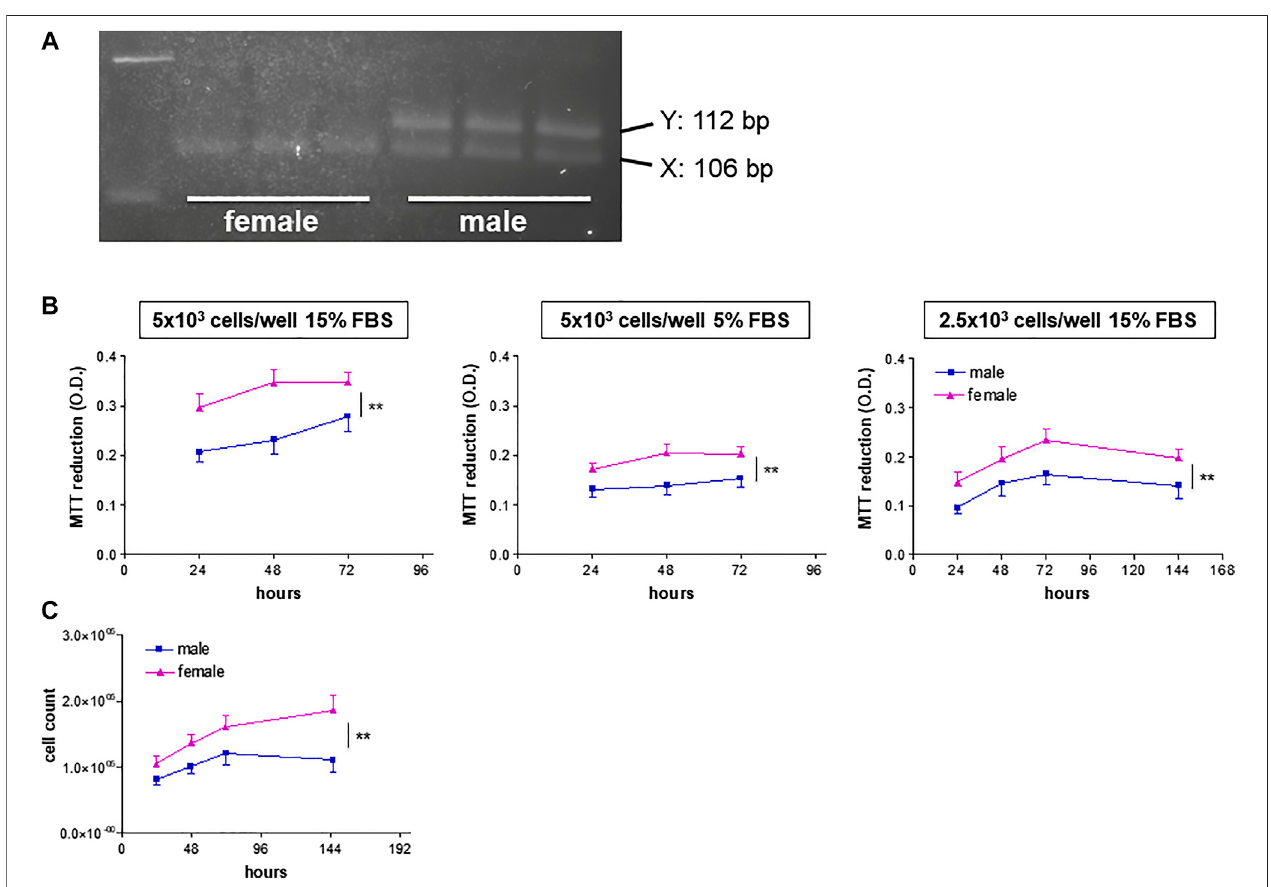
FIGURE 1 | Genotyping and growth rate of HUVECs from male and female donors. (A) Representative agarose gels of amelogenin PCR products from HUVEC DNA samples of female (left) and male (right) donors. (B) . HUVECs were plated in 96-well plates in M199 medium supplemented with ECGS (0.1 mg/ml) and heparin (100 IU/ml)attheindicatedFBSconcentrationsandseedingdensities.Cellviabilityisshownasopticaldensity(O.D.)values(MTTassays).Eachindependentexperiment ( n (cid:1) 4)wasperformedintriplicateusing cellsfromthreefemaleandthreemaledonors.Datarepresentmean ± SEMof12donors;two-way ANOVAforcomparison betweencurves,** p < 0.01. (C) .HUVECs(8 × 10 4 cells/well) wereplatedin6-wellplatesinM199medium supplementedwith15%FBS,ECGS(0.1 mg/ml)and heparin (100 UI/mL).Proliferation ratesare expressed asvitalcell countsafter Trypanblue stainingat indicatedtimepoints. Each independent experiment ( n (cid:1) 3)wasperformed in duplicate using cells from two female and two male individual donors. Data represent mean ± SEM of six donors; two-way ANOVA for comparison between curves, ** p < 0.01.